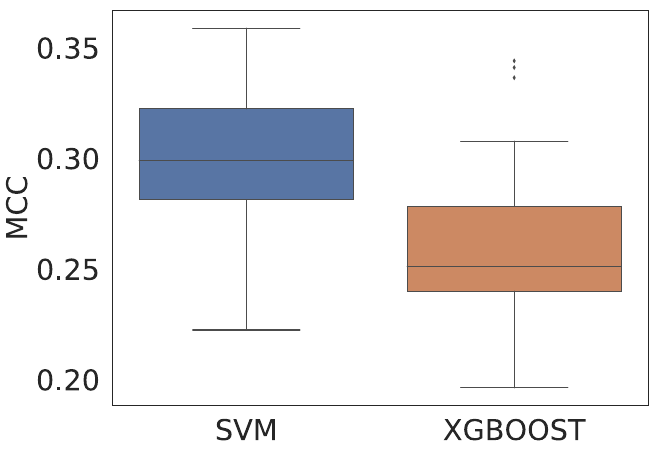
Figure A6. Boxplots of cross-validation MCC values for SVM and XGBoost models. p = 0.00103, Kruskal-Wallis multiple